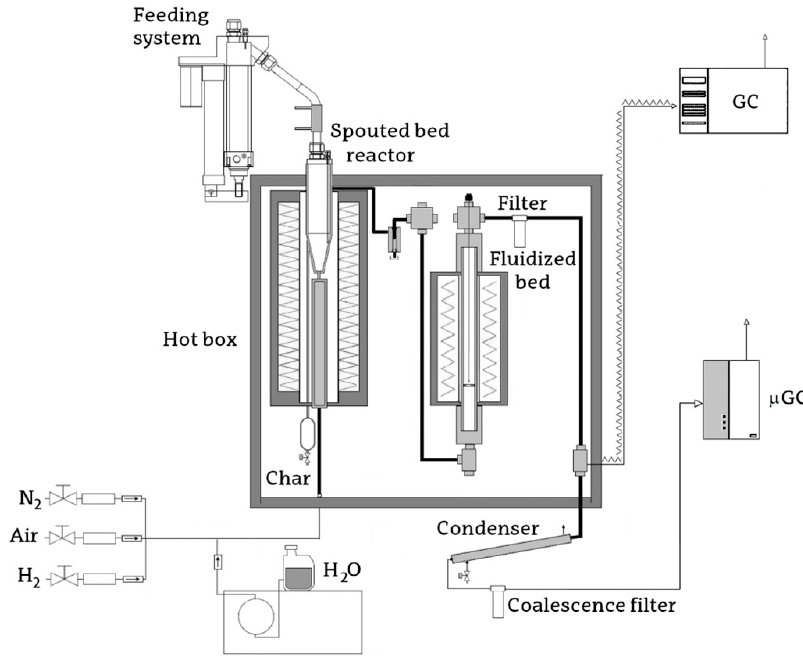
Figure 7. Scheme of the pyrolysis-reforming bench scale unit.